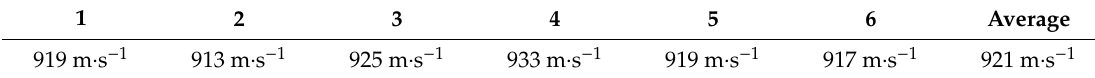
Figure 6. ( a ) Translational velocity and translational kinetic energy of the projectile, ( b ) rotational velocity and rotational kinetic energy of the projectile. Table 3. Projectile muzzle translational velocity measured by firing tests.